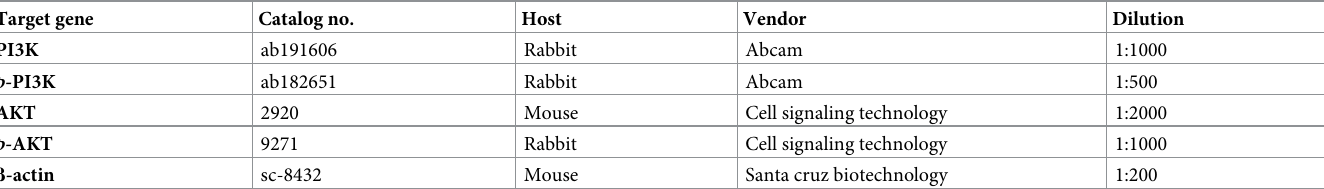
Table 1. Primary antibodies. Target gene Catalog